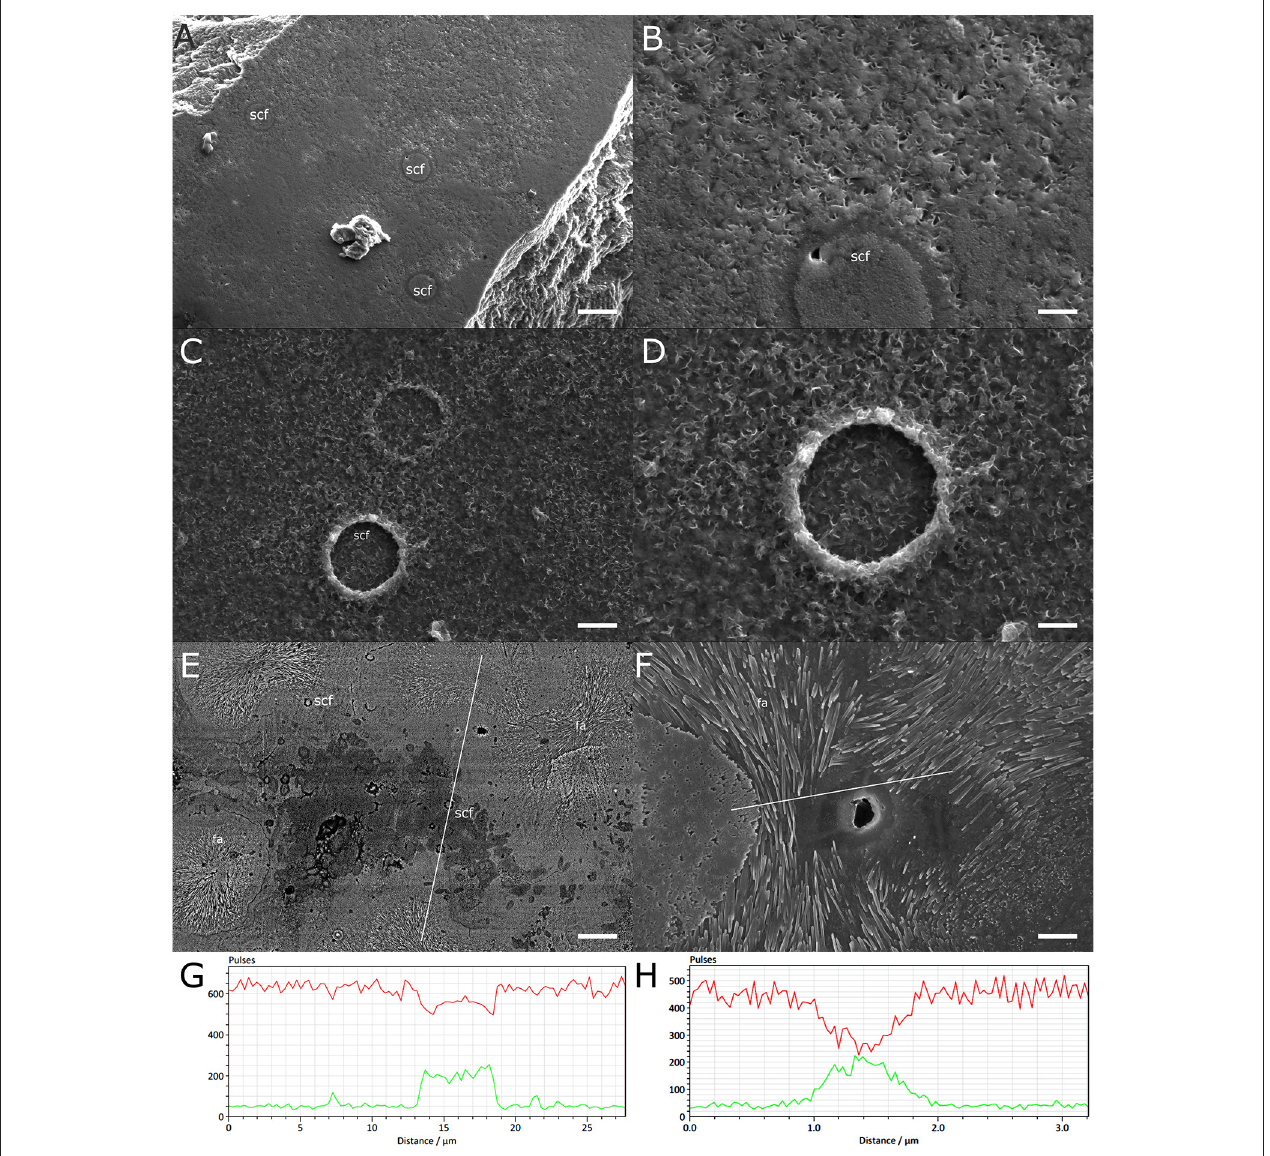
FIGURE 4 | High magnesium structures at the base of a P. damicornis colony grown on a glass surface. (A) Underside of the skeleton of a small colony, showing small circular features (scf) embedded in the skeletal matrix. Scale-2.5 µ m. (B) High magnification of the surface shown in (A) , showing an scf surrounded by a lattice similar to hml observed in micropropagates. Scale − 0.5 µ m. (C,D) Residues left on the glass surface following dissolution of the skeleton of a small P. damicornis colony by EGTA, preferentially chelating Ca over Mg. Scf structures are embedded in the hml and appear slightly raised. Scale − 1, 0.5 µ m for (C,D) , respectively. (E) Backscatter analysis of the underside of a small colony, with high Mg areas appearing darker. Multiple scfs are seen within the high Mg patch or surrounding it. Patches of radially growing fibrous aragonite (fa) surround the high Mg patch. White line marks the path of the EDS transect shown in (G) . Scale − 8 µ m. (F) A patch of radially growing fibrous aragonite surrounding a central pit. White line marks the path of the EDS transect shown in (H) . Scale − 2.5 µ m. (G,H) Changes in Ca (red) and Mg (green) levels along EDS transects from (E,F), respectively. High Mg/Ca ratios are evident within the dark patch in (E) and next to the pit in (F)